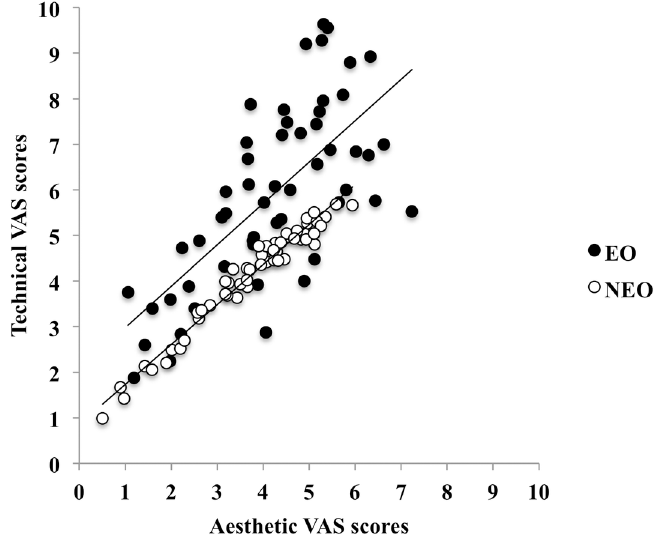
Fig 2. Technical(T) vs. aesthetic (A) qualities: VAS scores given to all swimmers (at slow and fast pace) by expert ([EO] full dots) and non-expert([NEO] open dots) observers.